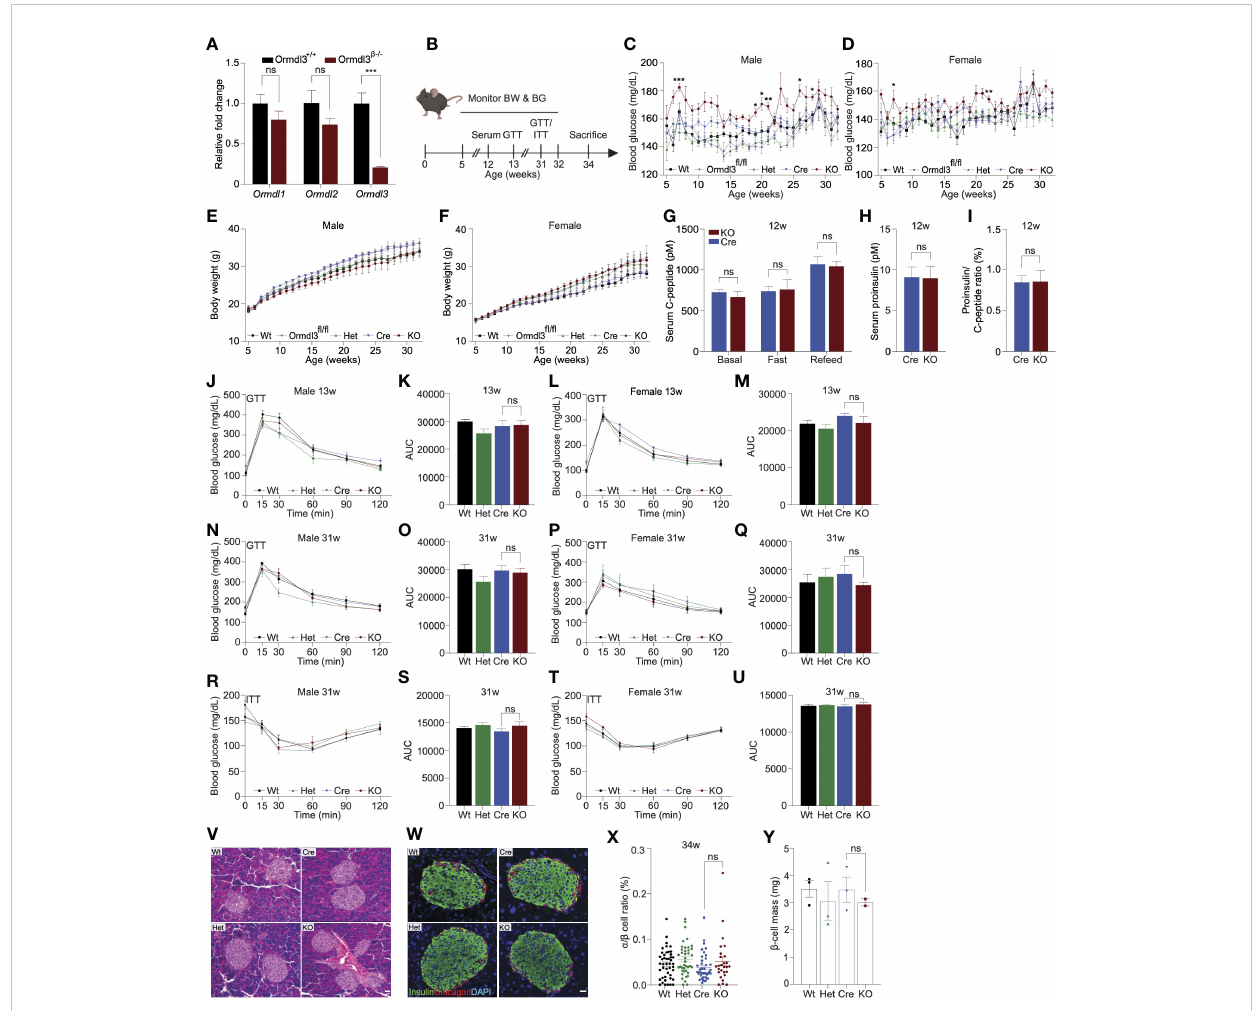
FIGURE 1 Chow-fed Ormdl3 b -/- mice do not exhibit altered b -cell function or glucose homeostasis. (A) Fold change gene expression of Ormdl isoforms in isolated islets of 7-week-old wild-type (Wt) and knockout (KO; Ormdl3 b -/- ) mice (n=3/group; Student ’ s t-test). (B) Schematic representation of mouse monitoring. (C) Weekly blood glucose measurements in Wt, Ormdl3 fl / fl , Cre, Heterozygous (Het; Ormdl b +/- ), and KO male (n=5-8/group) and (D) female (n=7-8/group) mice (Two-way ANOVA with Tukey ’ s post-hoc test; stars indicate signi fi cant differences between Cre and KO groups). (E) Weekly body weight measurements in Wt, Ormdl3 fl / fl , Cre, Het, and KO male (n=5-8/group) and (F) female (n=7-8/group) mice (Two-way ANOVA with Tukey ’ s post-hoc test). (G-I) ELISAs on serum samples from 12-week-old Cre and KO mice (Student ’ s t-test). (G) ELISA for C-peptide before/after a 6 hour fast and after 1 hour refeeding (n=5-6/group). (H) ELISA for proinsulin after 1 hour refeeding (n=5-6/group). (I) Ratio of proinsulin/C-peptide after 1 hour refeeding (n=5-6/group). (J-Q) Glucose tolerance and area under the curve (AUC) calculations for male and female Wt, Het, CO, and KO mice. (J) Glucose tolerance and (K) total area under the curve (AUC) of 13-week-old male mice (n=5-6/group; Two- and one-way ANOVA with Tukey ’ s post-hoc test, respectively). (L) Glucose tolerance and (M) total AUC of 13-week-old female mice (n=5-6/group; Two- and one-way ANOVA with Tukey ’ s post-hoc test, respectively). (N) Glucose tolerance and (O) total AUC of 31-week-old male mice (n=5-6/ group; Two- and one-way ANOVA with Tukey ’ s post-hoc test, respectively). (P) Glucose tolerance and (Q) total AUC of 31-week-old female mice (n=4/group; Two- and one-way ANOVA with Tukey ’ s post-hoc test, respectively). (R-U) Insulin tolerance and AUC calculations for 31-week-old male and female Wt, Het, Cre, and KO mice (R) Insulin tolerance and (S) total AUC of male mice (n=5-6/group; Two- and one-way ANOVA with Tukey ’ s post-hoc test, respectively). (T) Insulin tolerance and (U) total AUC of female (n=4/group; Two- and one-way ANOVA with Tukey ’ s post-hoc test, respectively). (V) Representative images of hematoxylin and eosin staining of 34-week-old male Wt, Cre, Het, and KO mice. (W) Co-staining for insulin and glucagon in pancreatic sections from 34-week-old male Wt, Cre, Het, and KO mice. (X) Ratio of a : b cells in co-stained insulin and glucagon sections (n=3/group; One-way ANOVA with Tukey ’ s post-hoc test). (Y) b -cell mass in insulin-stained sections (n=2-3/group; One-way ANOVA with Tukey ’ s post-hoc test). Data are presented as means ± SEM. One- and two-way ANOVA with Tukey ’ s post-hoc test (*p<0.05, **p<0.01, ***p<0.001, ****p<0.0001) and Student ’ s t-test (***p<.001) are applied where indicated. BW, body weight; BG, blood glucose; GTT, glucose tolerance test; ITT, insulin tolerance test; Wt, wild type; Ormdl3 fl / fl , Ormdl3 fl oxed mouse not expressing cre recombinase; Het, Ormdl3 b